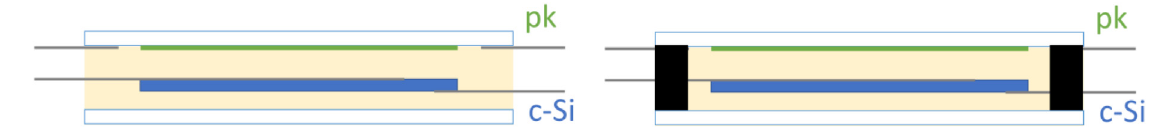
Fig. 2. Schematic pictures of the 100 cm 2 effective area bifacial 4T tandem device. Left: as used indoors; the edges are sealed by the encapsulant. Right: as used outdoors; additional sealing is applied around the